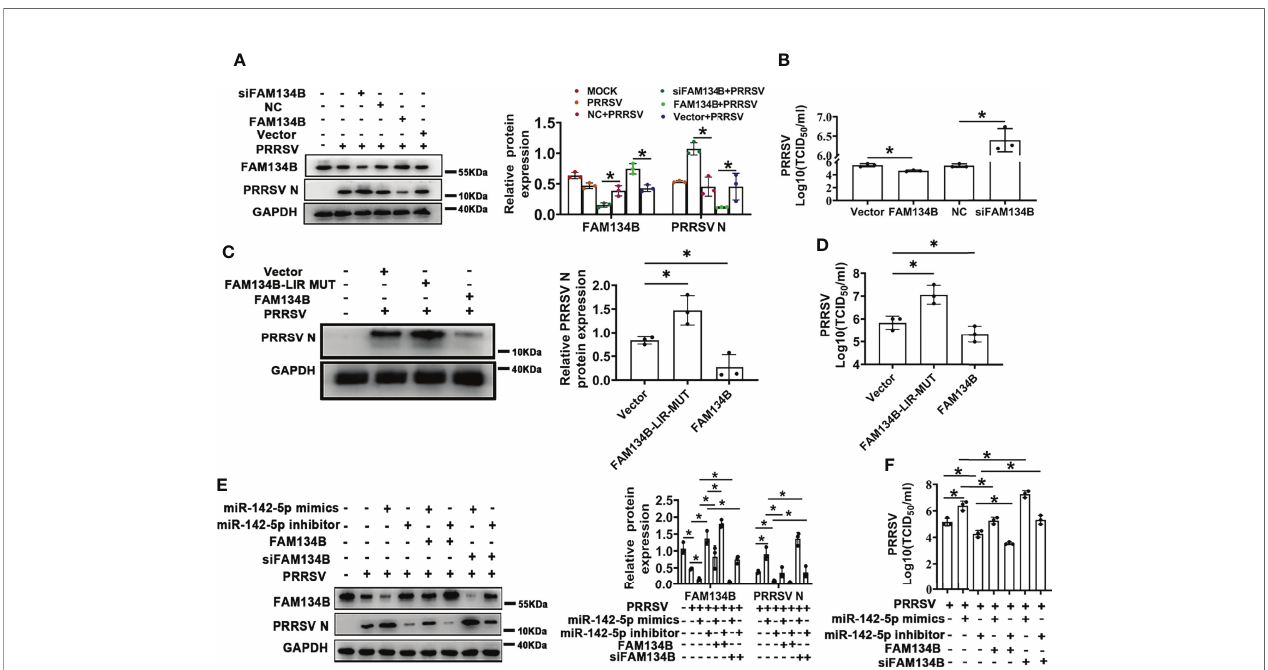
FIGURE 5 | FAM134B inhibits PRRSV replication. (A) Expression of FAM134B and PRRSV N protein in PK15 CD163 cells. FAM134B-overexpressed/FAM134B- depleted PK15 CD163 cells were infected with PRRSV (MOI=1) for 48 h, and were subjected to immunoblotting assay. * P <0.05, Kruskal Wallis test, n=3. (B) PRRSV titers in FAM134B-overexpressed or FAM134B-depleted PK15 CD163 cells by TCID 50 analysis. * P <0.05, Kruskal Wallis test, n=3. (C) Expressions of PRRSV N protein in PK15 CD163 cells. PK15 CD163 cells were infected with PRRSV (MOI=1) for 48 h after transfection with eGFP-FAM134B or eGFP-FAM134B- LIR-MUT. * P < 0.05, Kruskal Wallis test, n=3. (D) PRRSV titers in PK15 CD163 cells transfected with eGFP-FAM134B or eGFP-FAM134B-LIR-MUT by TCID 50 analysis. * P <0.05, Kruskal Wallis test, n=3. (E) Immunoblotting analysis of FAM134B and PRRSV N proteins in PK15 CD163 cells in different groups. * P <0.05, Kruskal Wallis test, n=3. (F) PRRSV titers in PK15 CD163 cells in different groups by TCID 50 analysis. GAPDH served as the control in immunoblotting assay. * P < 0.05, Kruskal Wallis test,